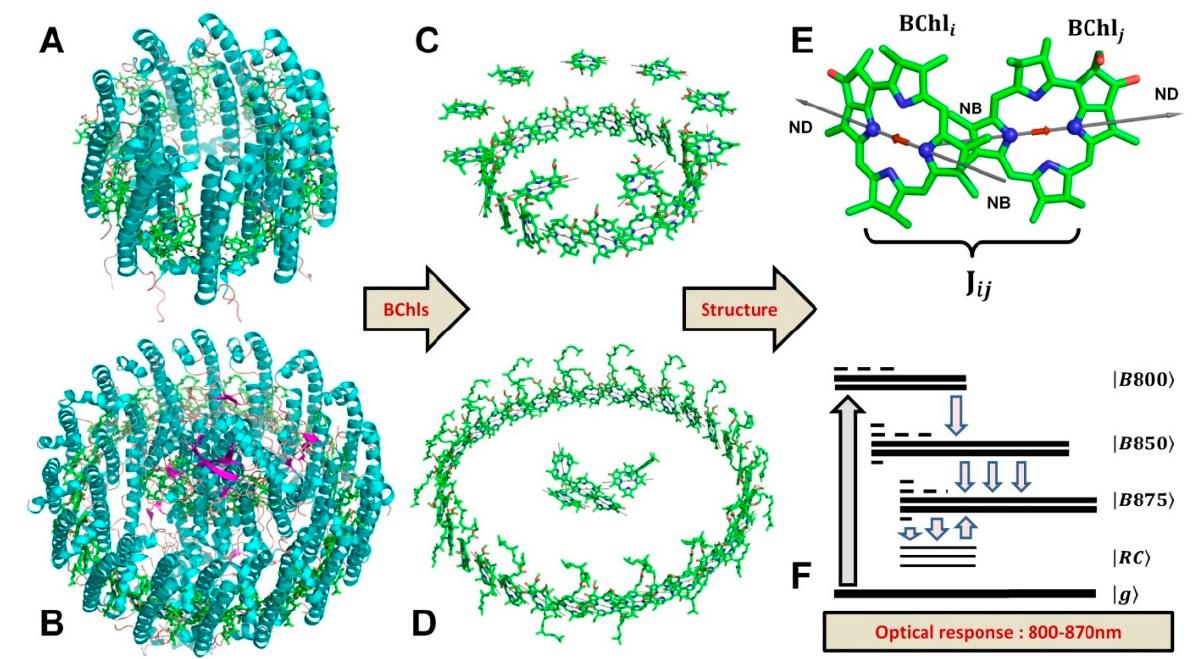
Figure 1. Crystal structures of LH2 from Rhodopseudomonas acidophila ( A ) and LH1-RC from Thermochromatium tepidum ( B ) illustrate typical molecular arrangements of peripheral ( A ) and core ( B ) light-harvesting complexes from purple bacteria. The protein framework of LH2 provides C n -type symmetry (in this case n = 9) for BChl molecules in the complex ( C ), whereas the arrangement of BChl molecules in LH1 ( D ) is more ellipse-like, which corresponds to C 2 symmetry. The optical properties of LH1-RC and LH2 in the 800–870 nm region are entirely determined by the Q y electronic excited state of BChl. The effective transition moment of this state is oriented roughly along the NB–ND direction of the porphyrin ring of BChl ( E ). The mutual orientation of BChl molecules in antennas and RC determines the interaction energies J ij between pigments, which, in turn, form an exciton manifold of antenna excited states and partially control the energy transport towards RC ( F ). X-ray data taken from the Protein Data Bank (https://www.rcsb.org/ accessed on 19 August 2021): 2fkw.pdb and 3wmm.pdb